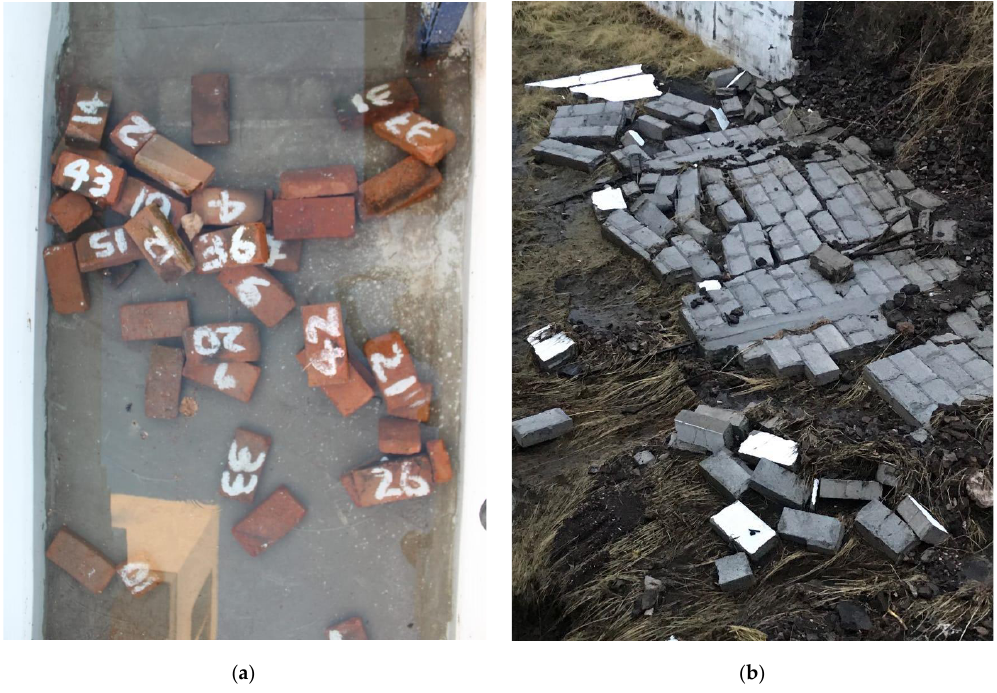
Figure 9. ( a ) Brick-wall failure induced in the forensic channel; ( b ) real brick-wall